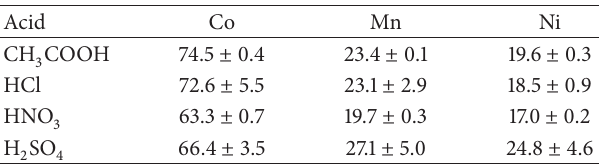
Table 2: Percentage of minor metals coleached with zinc in pH 5 leaching solutions. Acid Co